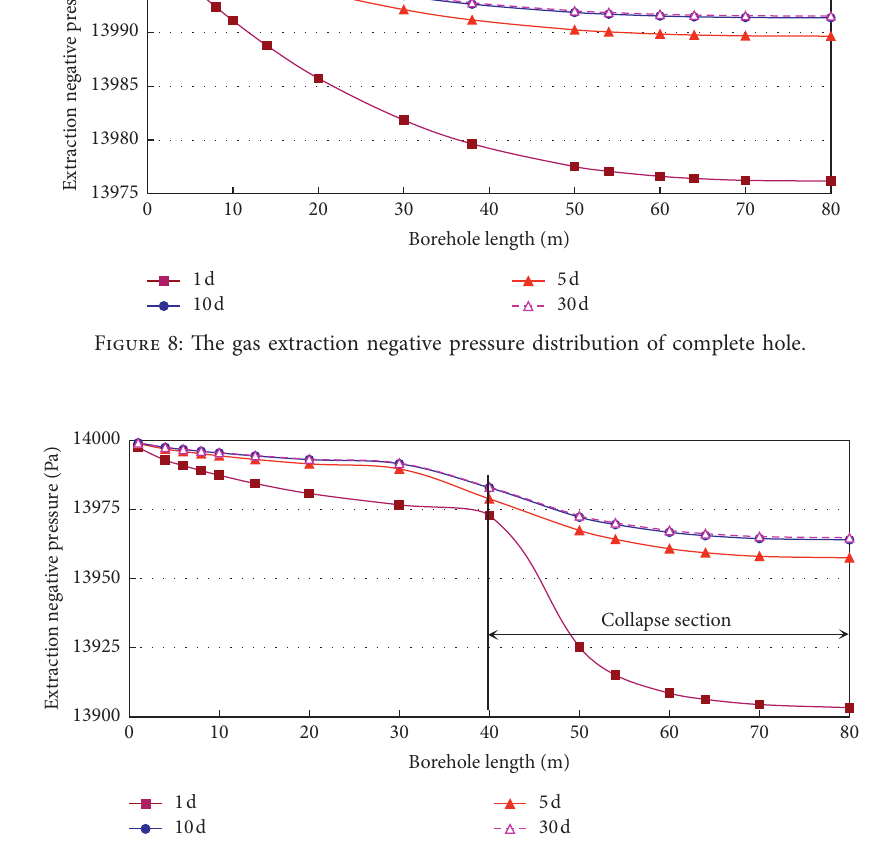
Figure 9: The gas extraction negative pressure distribution of collapsed